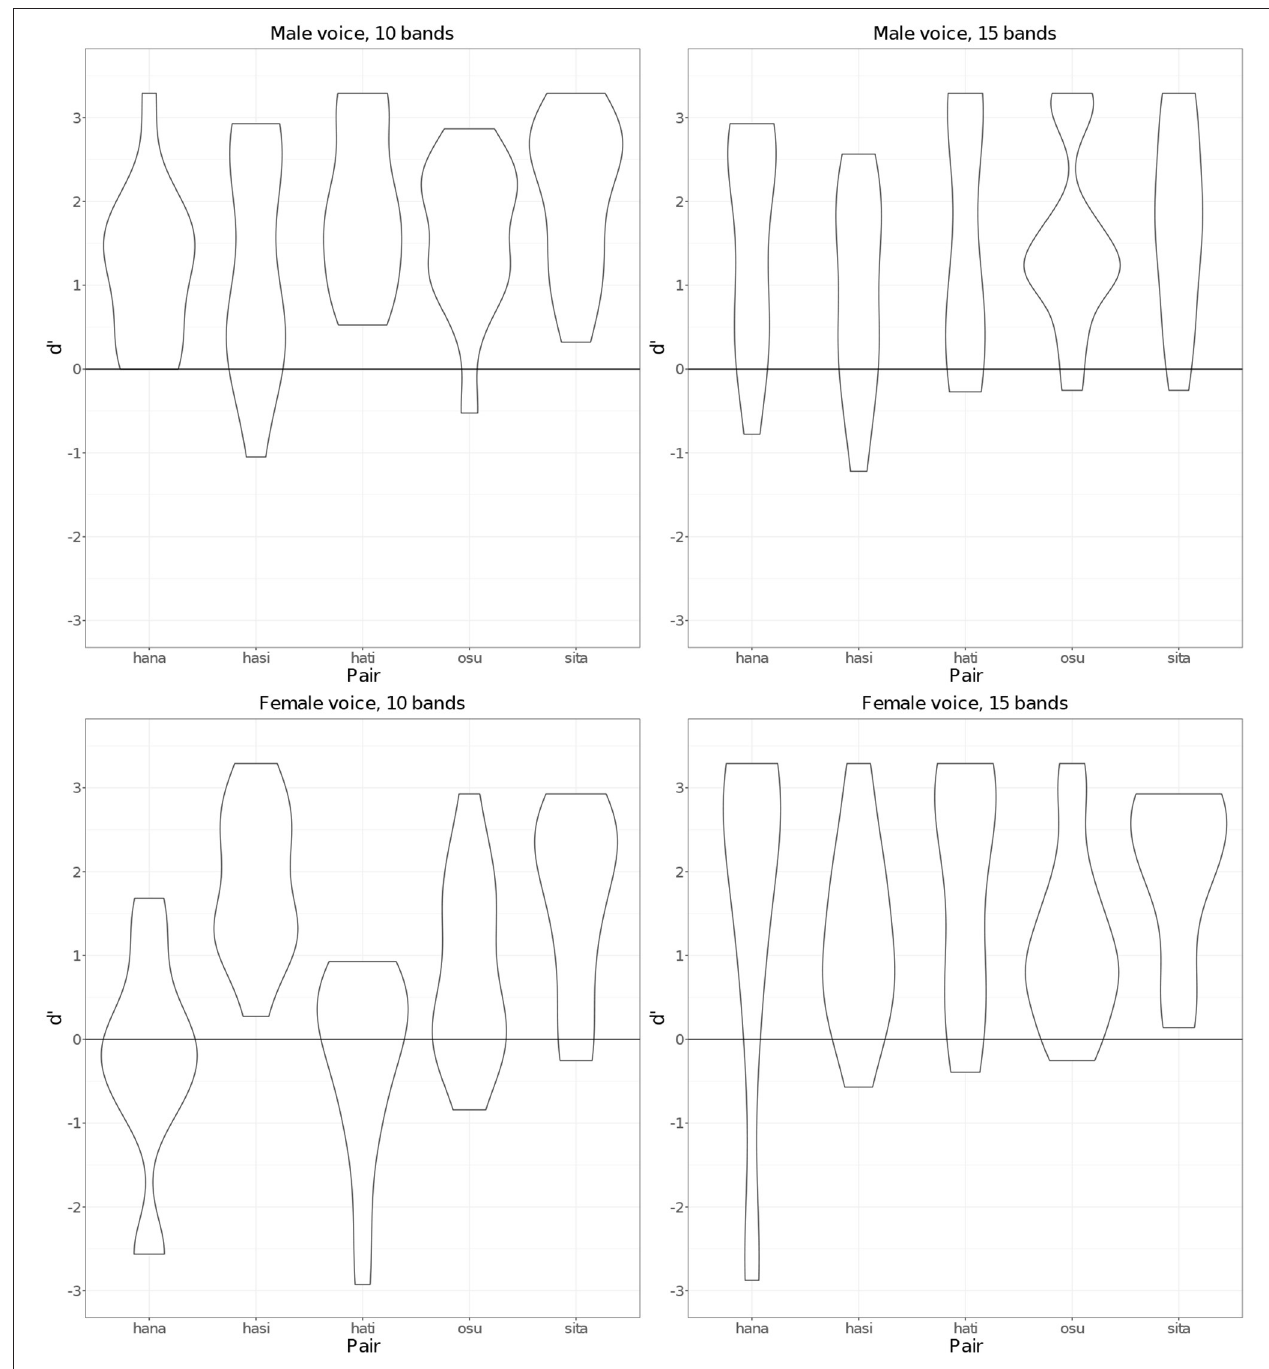
FIGURE 7 | d’ scores by pairs for 10 and 15 frequency bands in male and female voices.